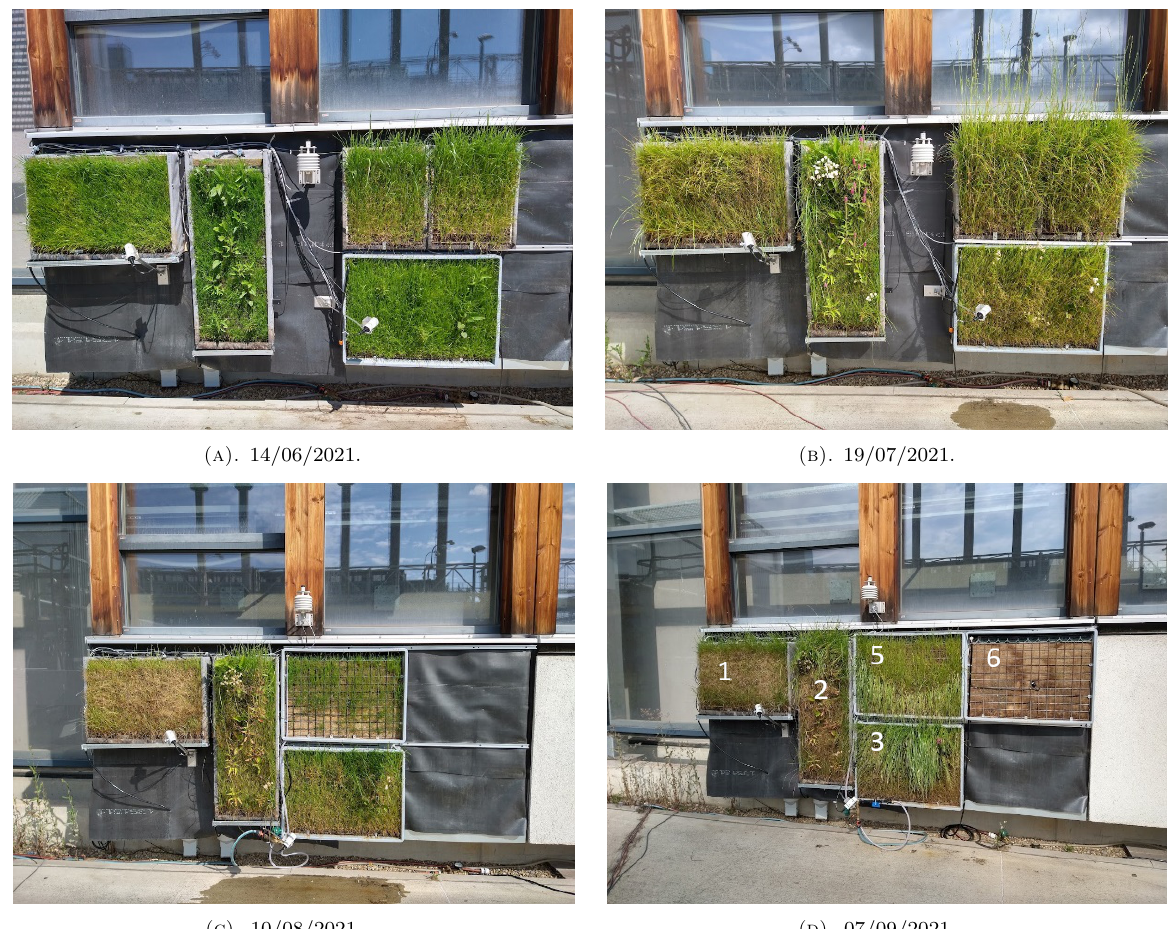
Figure 4. Photographs of test façade – selected days in growing season 2021.